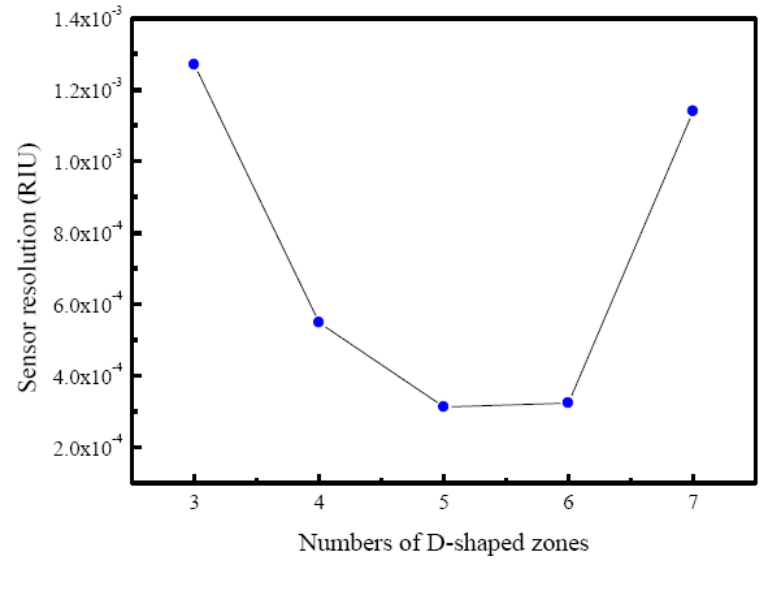
Figure 12. Plot of sensor response versus the number of D-shaped